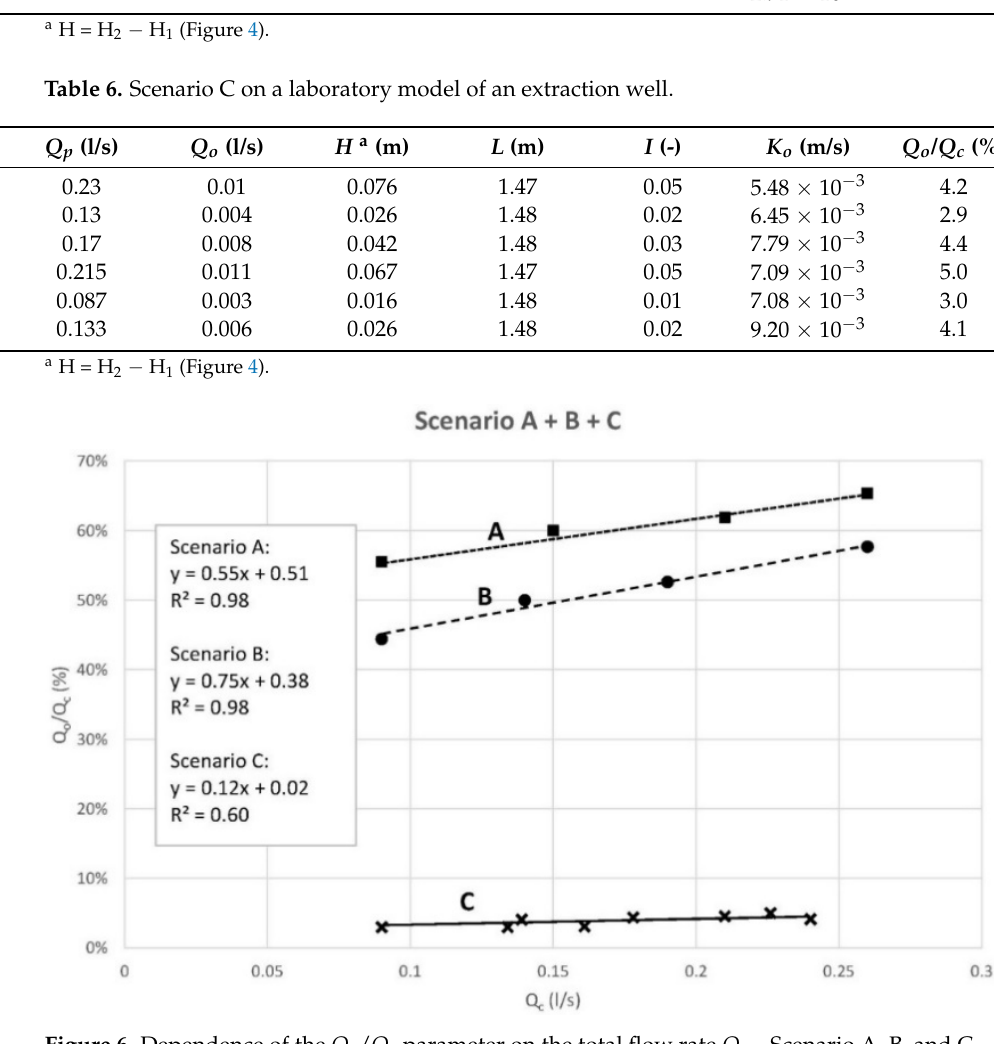
Table 6. Scenario C on a laboratory model of an extraction well.